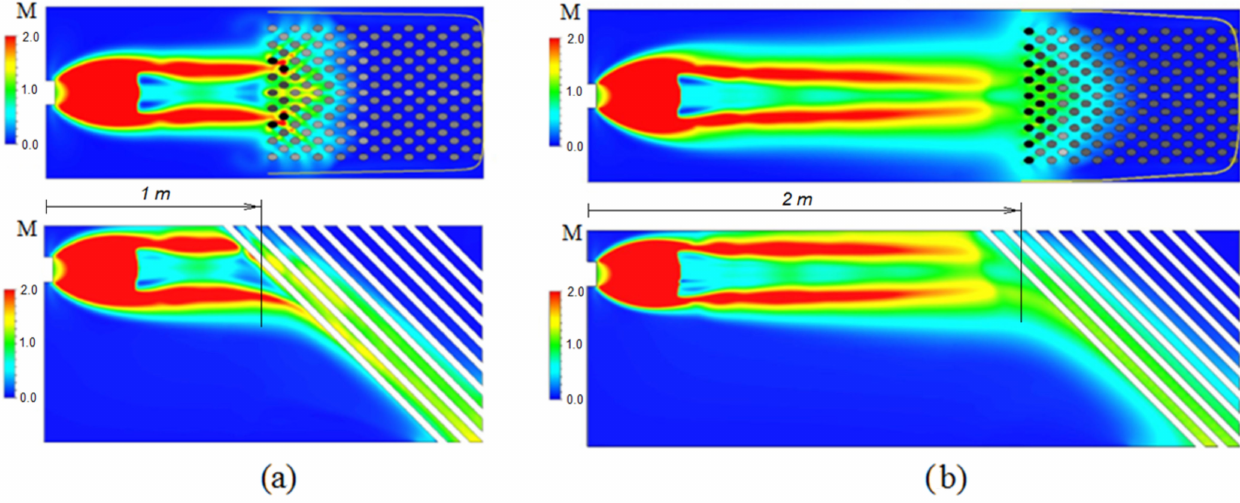
Figure 7. Blowing of the tube package by an air jet with a pressure of P 0 = 2.35 MPa. ( a ) Case 11; and ( b ) case 15. Upper—XOY plane, lower—XOZ